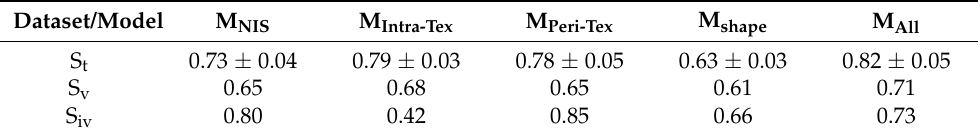
Table A5. The accuracy of the M NIS and other radiomic models in distinguishing adenocarcinomas from granulomas on S t , S v and S iv